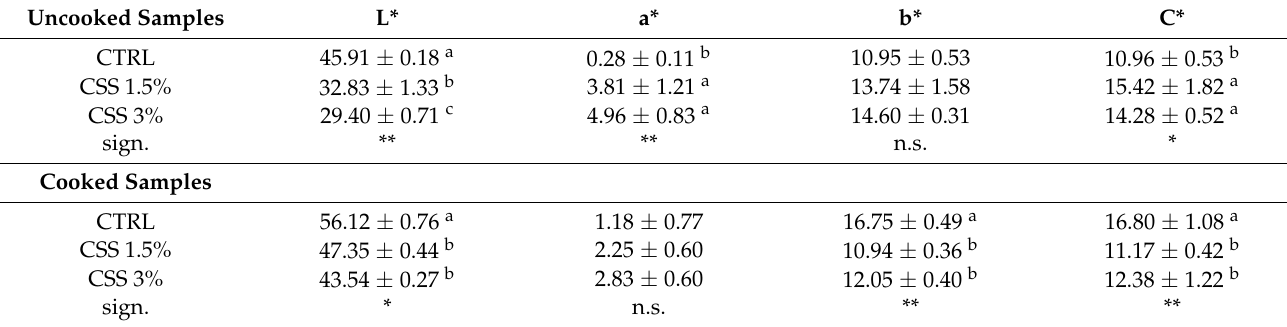
Table 3. Colour values (mean ± SD) of L* (lightness), a* (redness), b* (yellowness), and C* (chroma) for uncooked burgers and cooked burgers, in control (CTRL) and in samples with +1.5% (CSS 1.5%) and +3.0% (CSS 3.0%) of coffee silver skin as